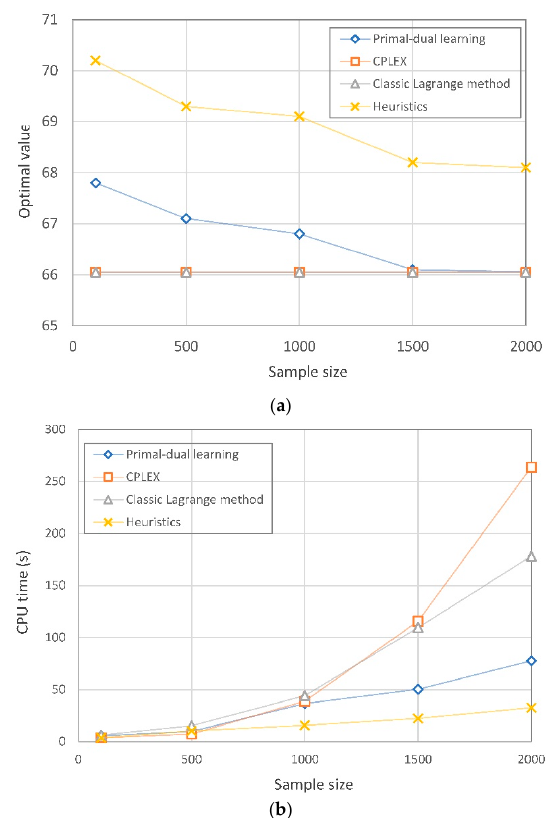
Figure 3. Performance of the proposed algorithm compared to some benchmarks: ( a ) optimal value of costs under different sample sizes; ( b ) CPU time under different sample sizes.